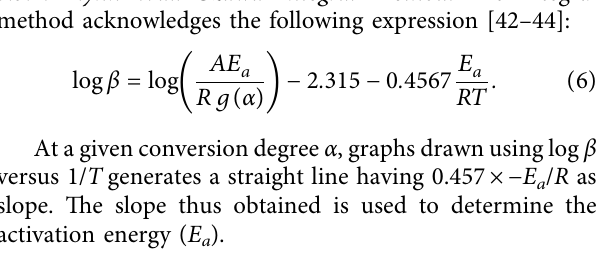
Ingredients (Phr a